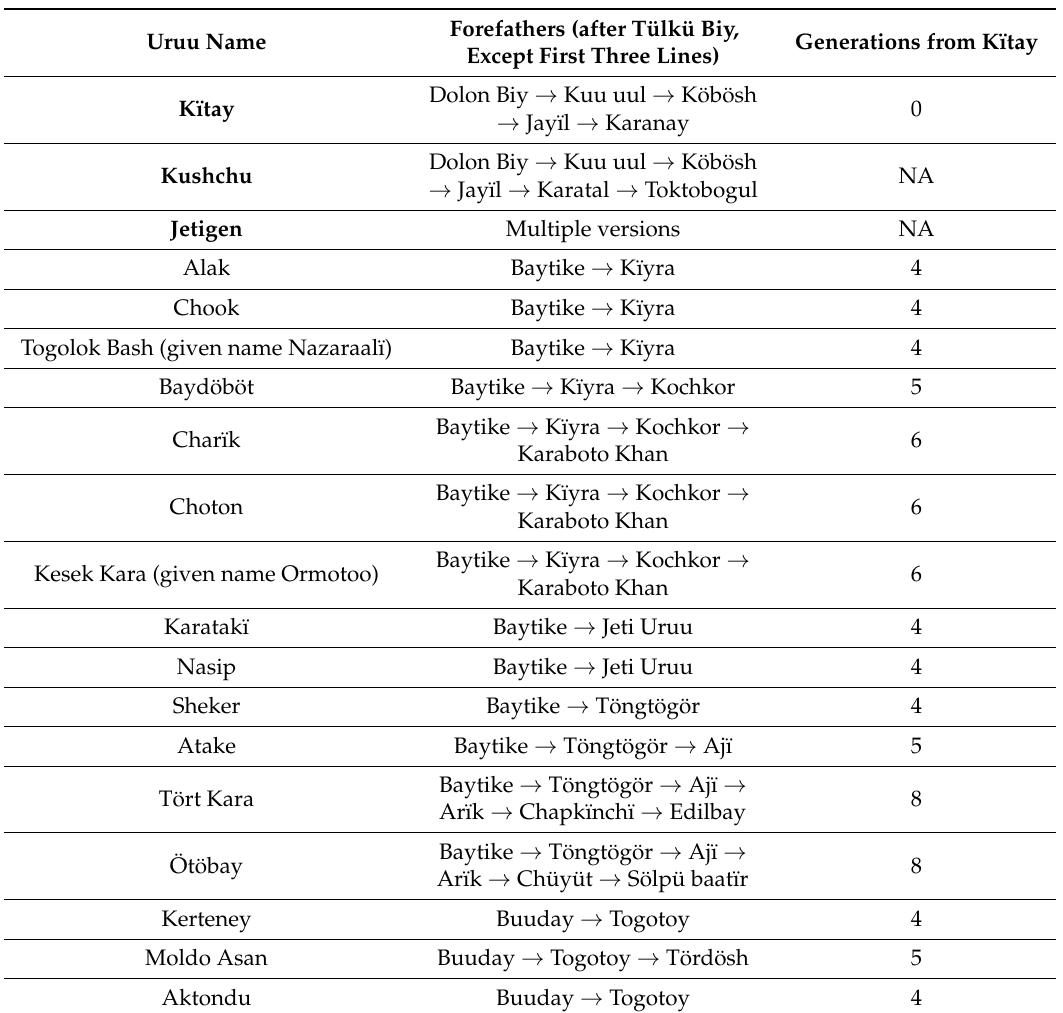
Table 1. Kïtay lineages and their vertical generational distances. The first three rows (in bold) compare the descent of Kïtay with two other Kara Buura top-level lineages. The subsequent lineages descend from Baytike and Buuday, sons of Tülkü Biy, son of Kïtay. Each of the lineages listed below includes at least 100 households in the Kara Buura district. These data come from a variety of local oral and written